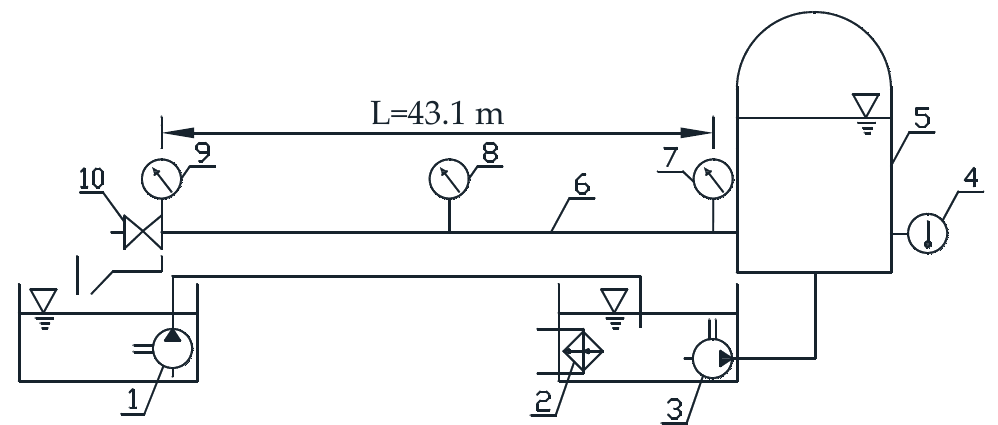
Figure 2. Schematic diagram of Güney’s experimental test stand: 1—booster pump, 2—temperature stabilization system, 3—test stand supply pump, 4—thermometer, 5—reservoir, 6—LDPE pipe, 7, 8, and 9—pressure transducers, 10—quick-closing valve.